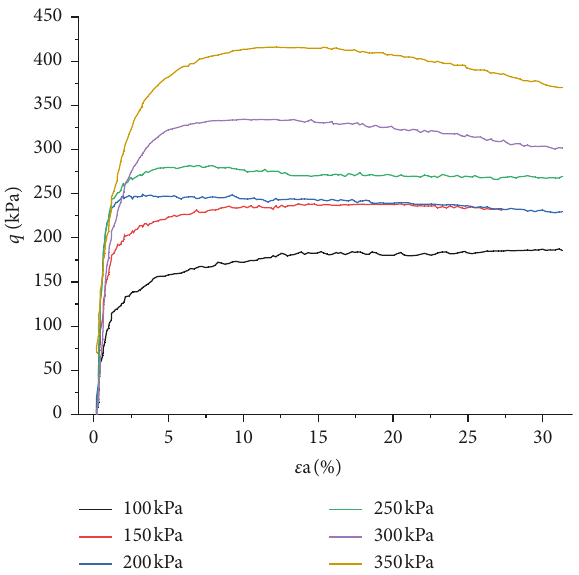
Figure 4: Stress-strain curves of silty clay Figure 6. The mesh applied in this model consisted of 37,254 nodes and 73,193 elements. Dimensions of the soil body were selected to be 120 m (length) × 120 m (width) × 65 m (depth). The soil mass, four-pile caps, and tunnel linings were simulated using tetrahedron elements. The shield and bridge deck were simulated as plate elements. And the beam elements were used in piles. In this model, soil mass and piles were considered as continuum solids. The shield machine was simplified as a continuum shell. Tunnel linings were simulated as continuum solids without taking into account the joints. To simulate the boundary conditions, displace- ment of the four vertical boundaries was set to be zero in the horizontal direction and left free to settle vertically. Fur- thermore, the bottom boundary was fixed, and the top boundary was free.